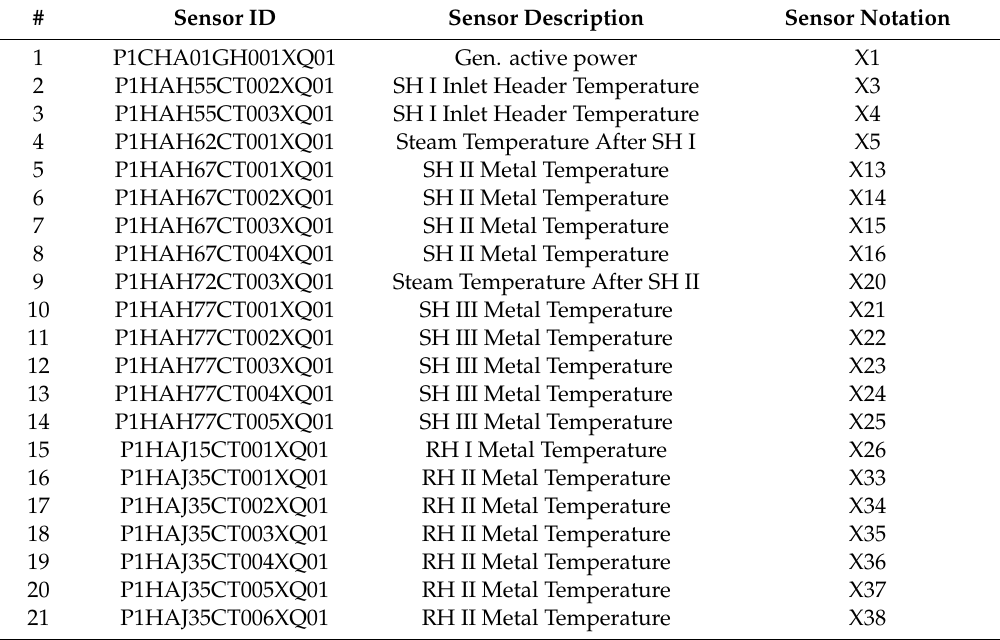
Table 3. List of optimal sensors determined by the correlation